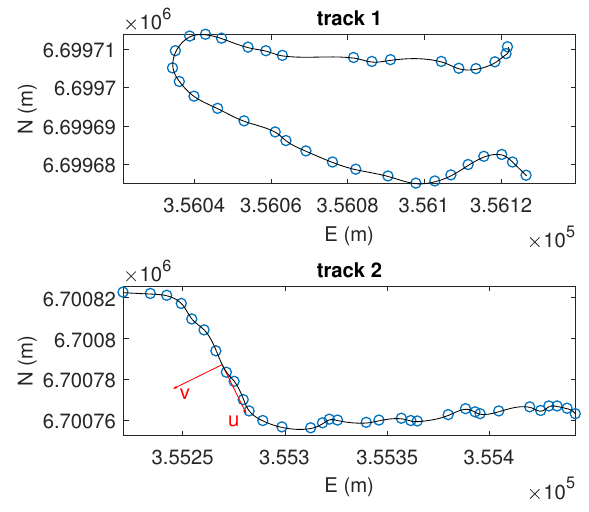
Figure A4. The trail central line detection by height convolution maximization. The local coordinates ( u , v ) are the same as in Figure